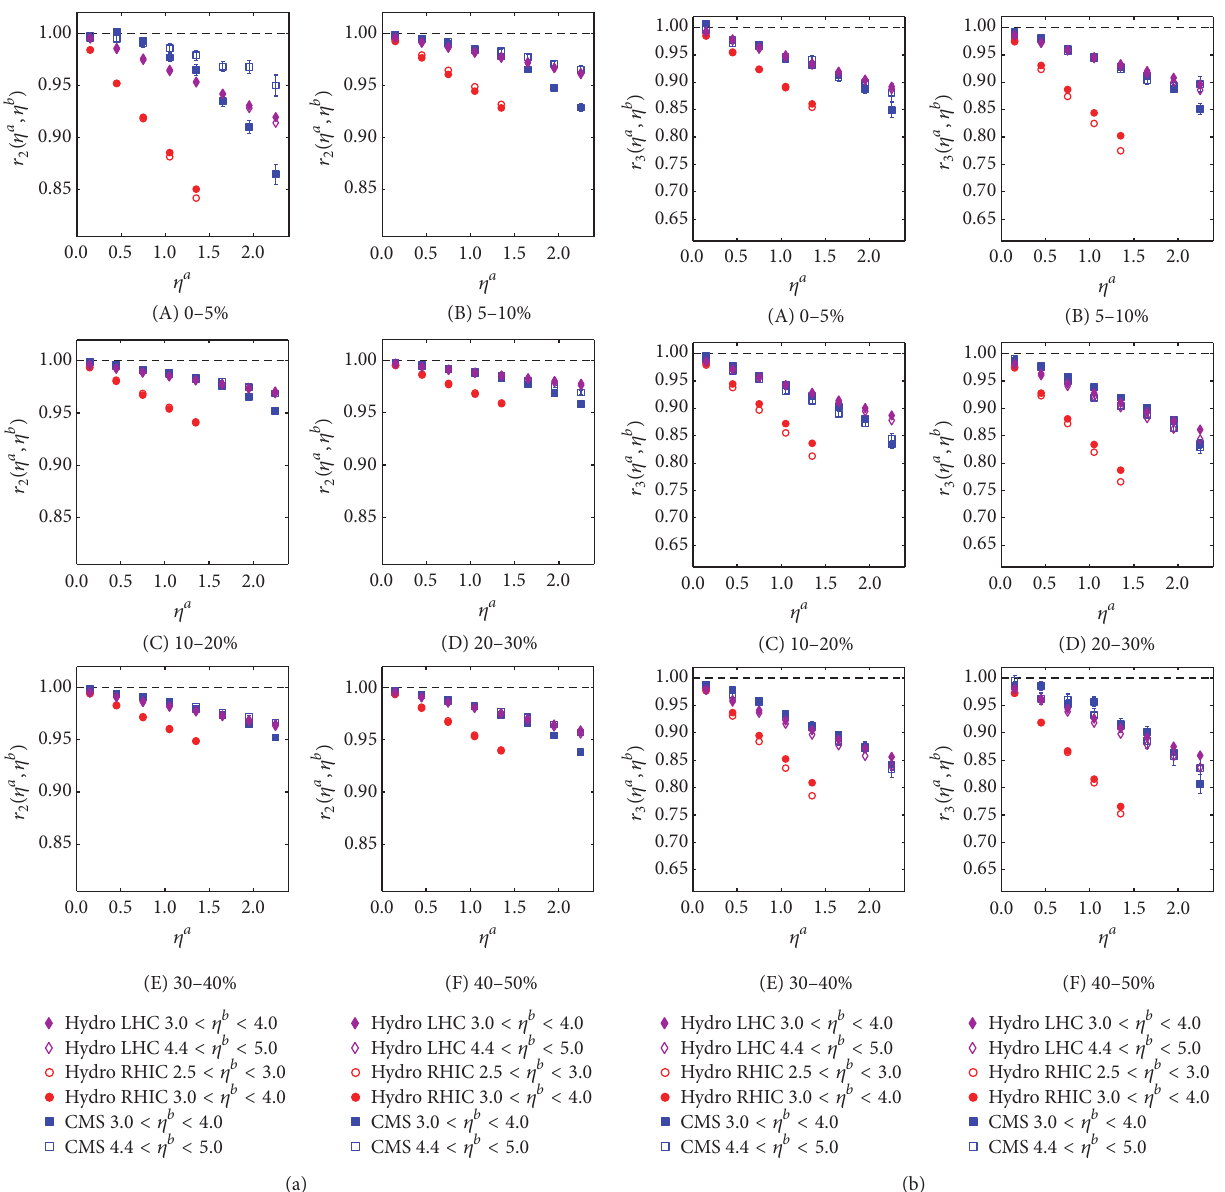
Figure 13: (a) The factorization ratio 𝑟 2 as a function of space-time rapidity 𝜂 𝑎 for two different reference rapidity bins 3.0 < 𝜂 𝑏 < 4.0 and = 2.76 TeV (open and solid diamonds) and for 2.5 < 𝜂 𝑏 < 3.0 and 3.0 < 𝜂 𝑏 < 4.0 in Au-Au collisions 4.4 < 𝜂 𝑏 < 5.0 in Pb-Pb collisions at √𝑠 NN = 200 GeV (open and solid circles) from event-by-event (3+1)D ideal hydrodynamics simulations compared with experimental data at √𝑠 NN = 2.76 TeV (empty and solid squares). (b) shows the factorization ratio 𝑟 from CMS collaboration [212] for Pb-Pb collisions at √𝑠 NN figures are from [207].